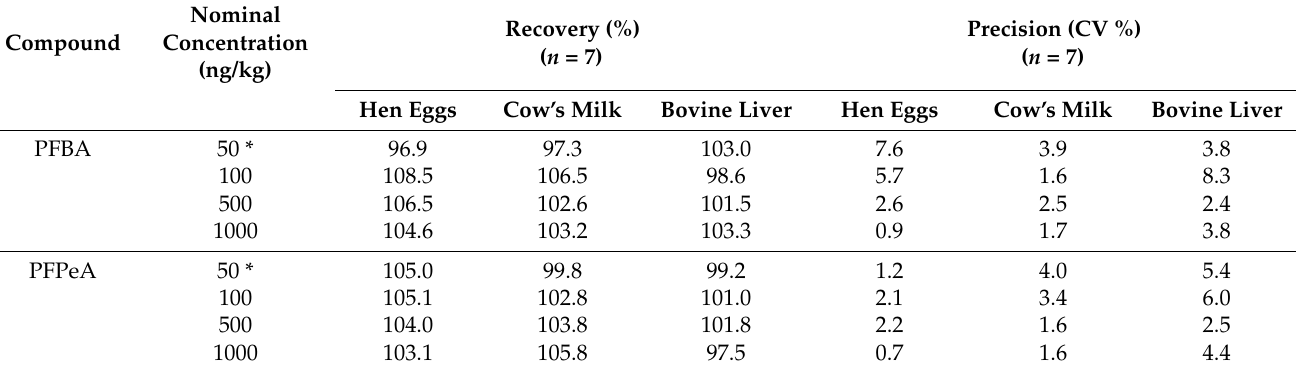
Table 1. Method recovery and repeatability in hen eggs, cow’s milk, and bovine liver intraday measurements (one blank sample spiked with four different concentrations, seven replicates for each